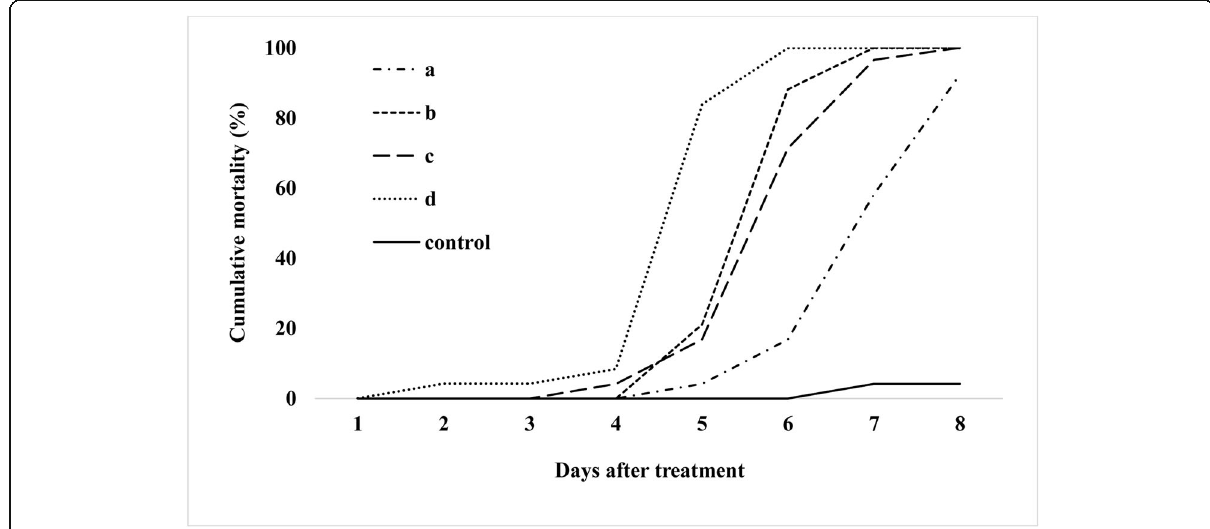
Fig. 1 The efficacy of Metarhizium anisopliae against Callosobruchus maculatus adults. a 22 ± 1 °C, 1 × 10 6 conidia ml − 1 ; b 26 ± 1 °C, 1 × 10 6 conidiaml − 1 ; c 22 ± 1 °C, 1 × 10 8 conidia ml − 1 ; d 26 ± 1 °C 1 × 10 8 conidiaml −